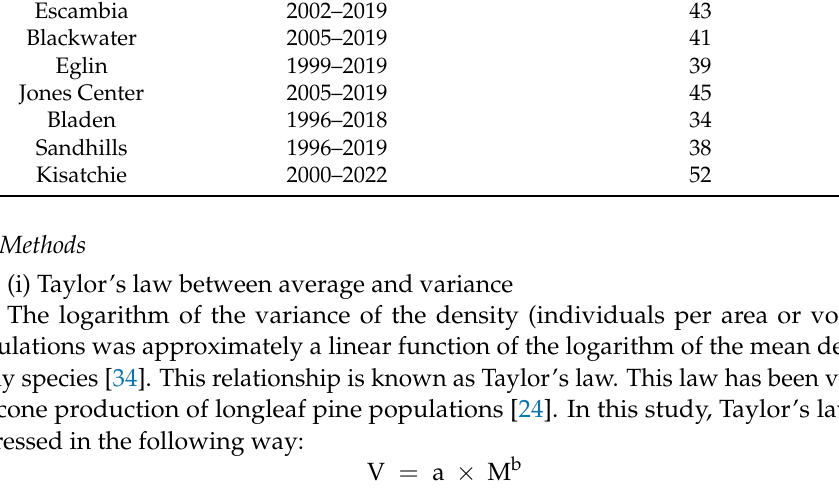
Table 1. Year of cone count initiation and average tree diameter at the study sites. Sites Included Time Average DBH at the Start of Analysis (cm)